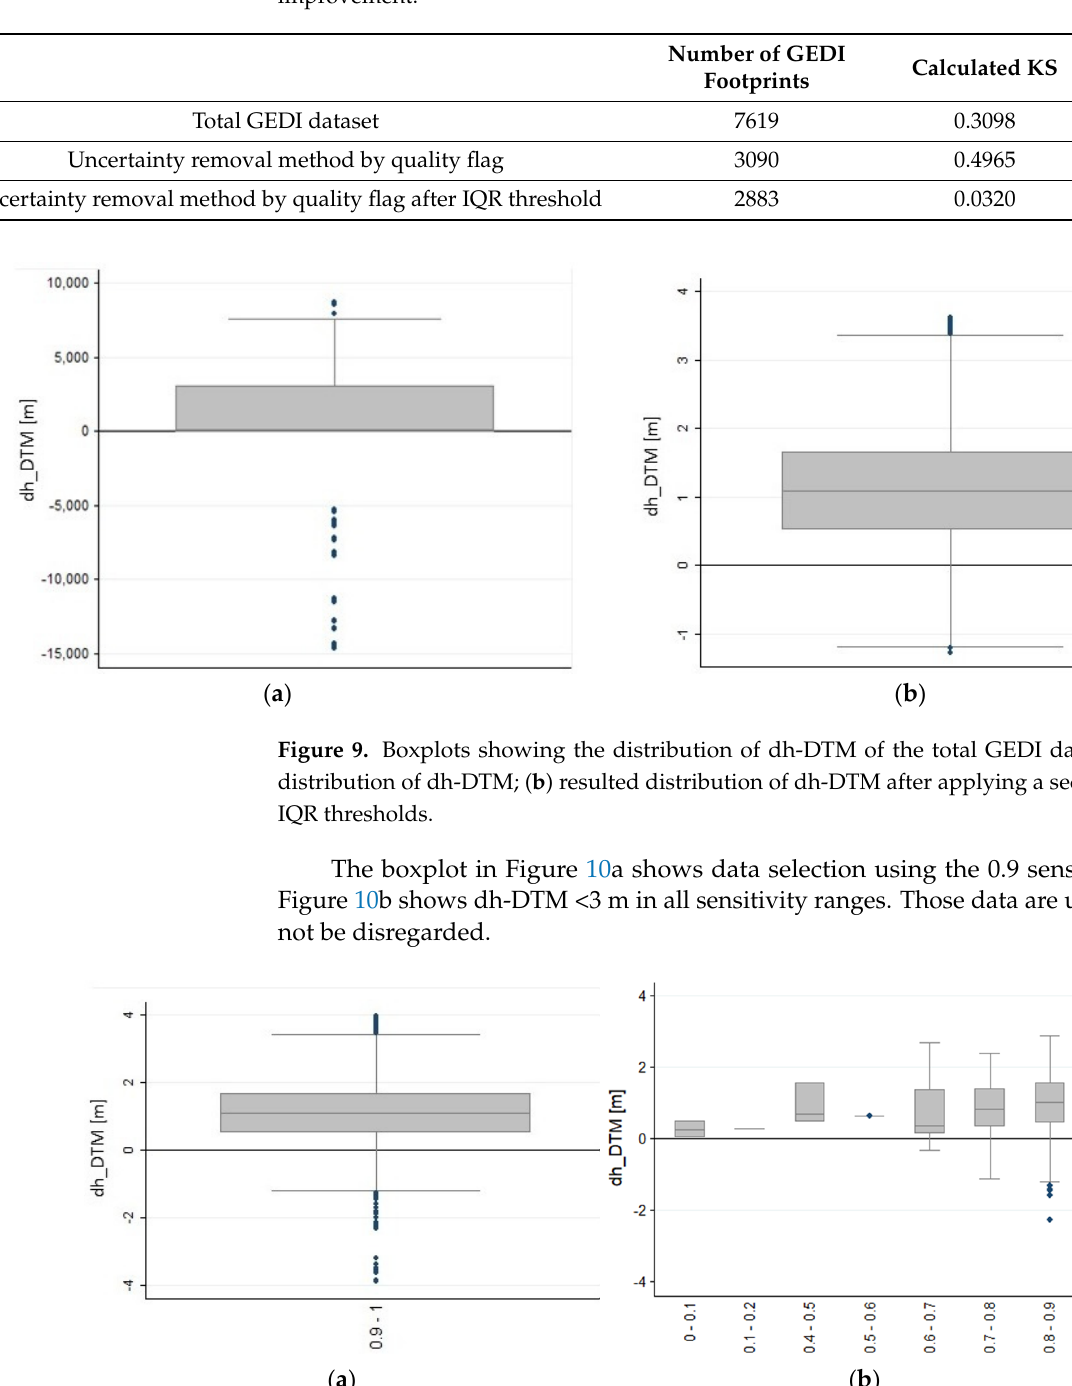
Table 4. Statistics from the dh-DTM quality flag to remove uncertainties and its IQR threshold improvement.